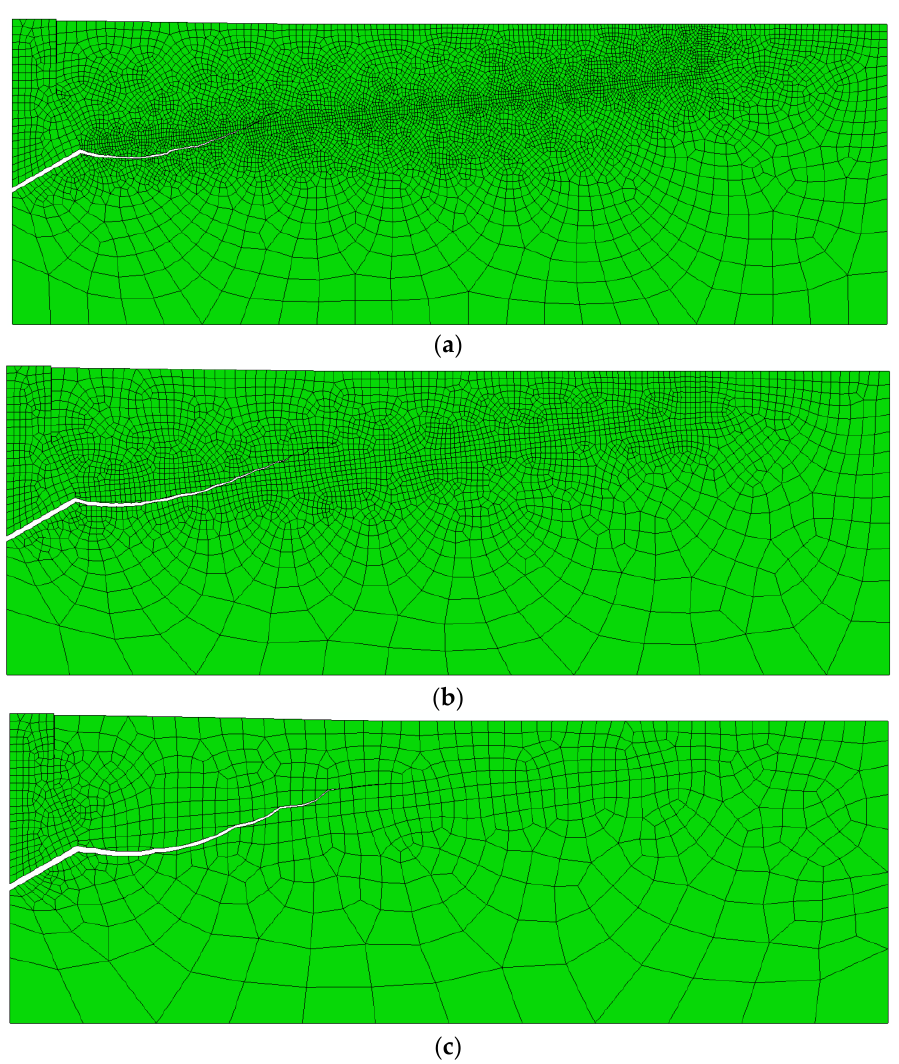
Figure 8. Model sensitivity to finite element mesh element size: ( a ) Δ = 1 mm, ( b ) Δ = 2 mm, and ( c ) Δ = 5 mm.